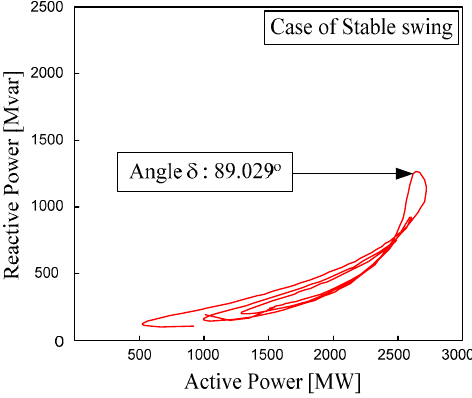
Figure 9. The trajectory of complex power on the complex power plane (the fault clearing time is one cycle).